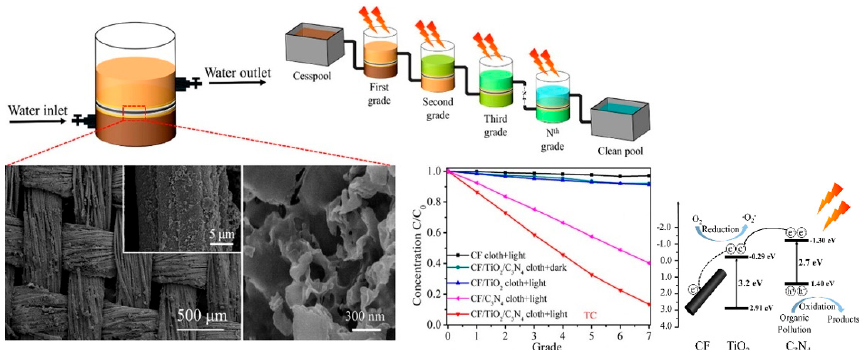
Figure 15. Summary of the PM process using a TiO 2 /C 3 N 4 /CF cloth filter membrane for pollutant degradation under light radiation with high desired morphological, good performance, and schematic mechanism of electron-hole separation [104]. Reproduced with permission from Elsevier, 2022.